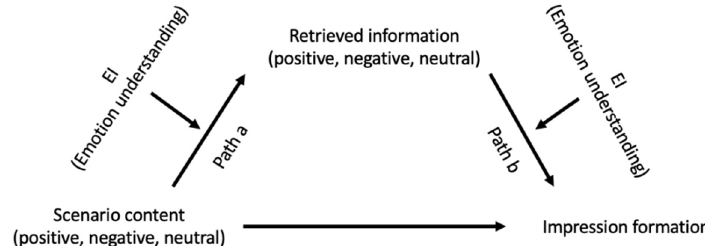
Figure 1. Illustration of Hypothesis 3 and 4 (moderated mediation).